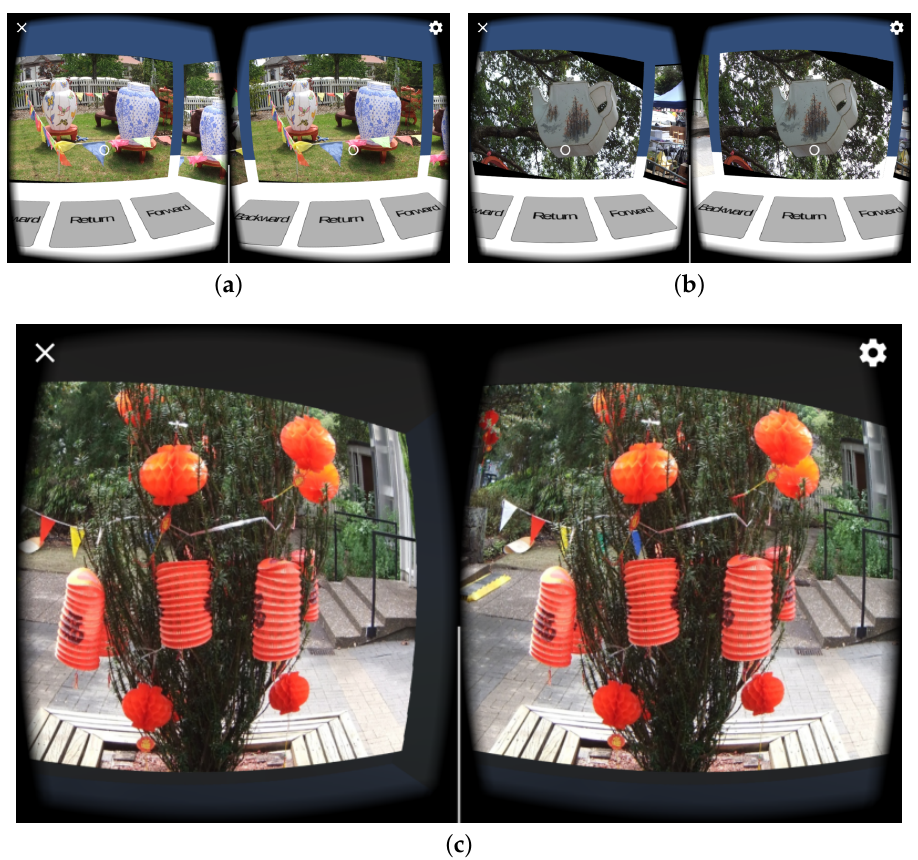
Figure 10. Screen-shots of our current application. ( a ) Demo screen shot 1; ( b ) Demo screen shot 2; ( c ) Demo screen shot